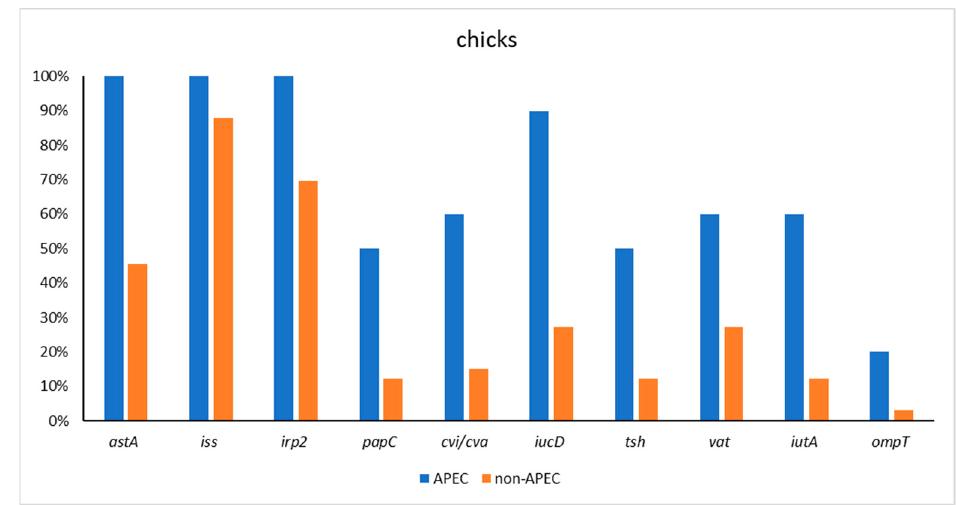
Figure 1. Virulence gene distribution E. coli APEC and non ‐ APEC strains in day old chicks.